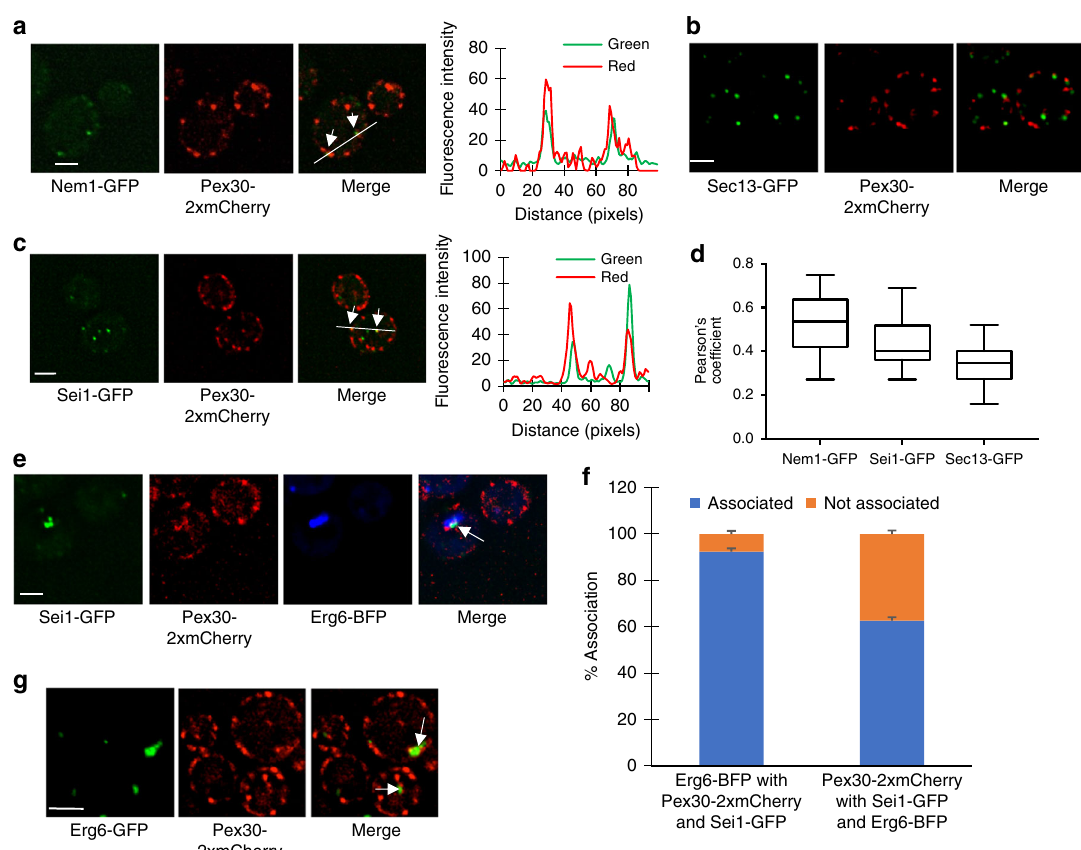
Fig. 2 Pex30 subdomains associate with LD biogenesis proteins. a – c Wild-type cells expressing endogenously tagged Pex30-2xmCherry and Sei1-GFP ( a ), Sec13-GFP ( b ), or Nem1-GFP ( c ) were grown in SC to early stationary growth phase and visualized live. Arrows indicate sites where Pex30-2xmCherry associates with other markers. Graphs to right of a and c show signal intensity on white line. d Pearson ’ s coef fi cient for colocalization of Pex30-2xmCherry punctae associated with Nem1-GFP, Sei1-GFP, and Sec13-GFP; n ≥ 50 cells. The box covers the 25 th to 75 th percentiles, the whiskers mark the highest and lowest values and the median is indicated. e Wild-type cells expressing endogenously tagged Pex30-2xmCherry and Sei1-GFP and Erg6-BFP expressed from a 2 μ plasmid were grown in SC to early stationary growth phase and visualized live. Arrow indicates site where Pex30-2xmCherry associates with other markers. f Quanti fi cation of experiment shown in e . Values are mean + / – s.d. of three independent experiments. g Wild-type cells expressing endogenously tagged Pex30-2xmCherry and Erg6-GFP were grown in SC to early stationary growth phase and visualized live. Arrows indicate sites where Pex30-2xmCherry and Erg6-GFP associate. Bars = 3 μ m. In a – c and g stacks of three images with a step size of 0.25 μ m were deconvolved; images from a single plane are